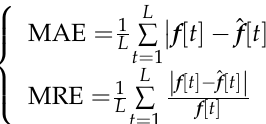
Figure 14. First-order natural frequency predicted results in different milling stages; line: experimental values; dot : estimated values.